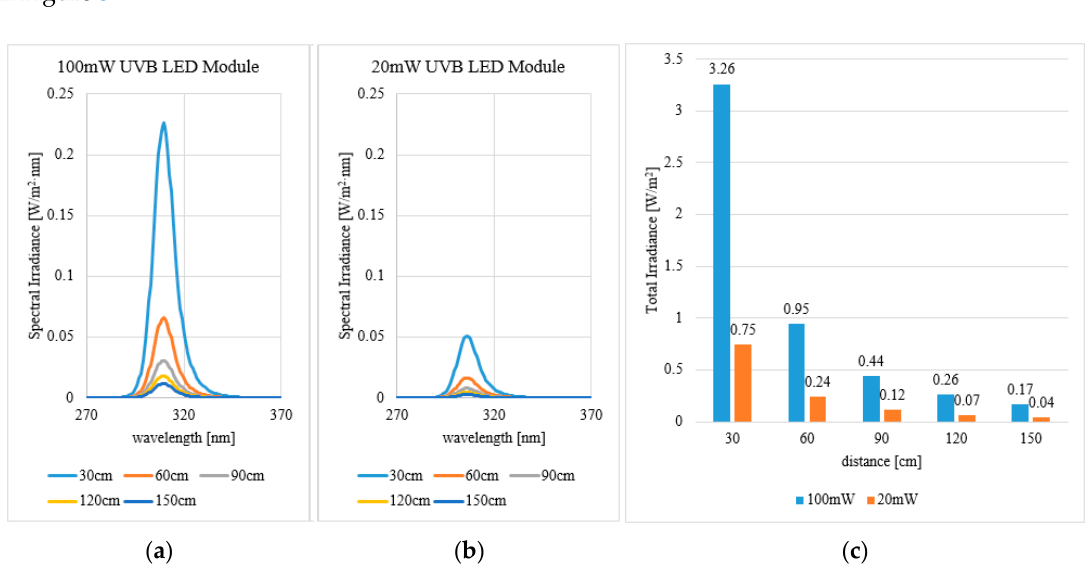
Table 4. Irradiance of the UVB LED light source modules by applied current. (distance: 150 cm) (unit: W/m 2 ).